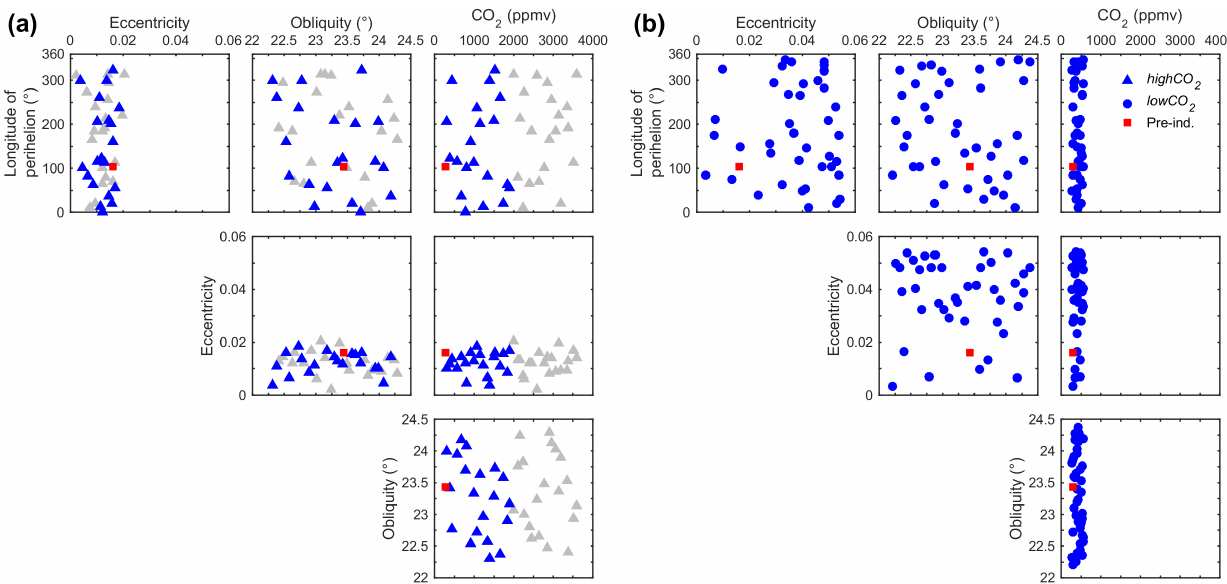
Figure 2. Distribution of 40 experiments produced by Latin hypercube sampling, displayed as two-dimensional projections through four- dimensional space. (a) high CO 2 ensemble and (b) low CO 2 ensemble. The variables are eccentricity ( e ), longitude of perihelion ( (cid:36) , ◦ ), obliquity ( ε , ◦ ) and atmospheric CO 2 concentration (ppmv). A pre-industrial control simulation is shown in red. In the high CO 2 ensemble, experiments with CO 2 concentrations of more than 2000ppmv, shown in grey, were excluded from the